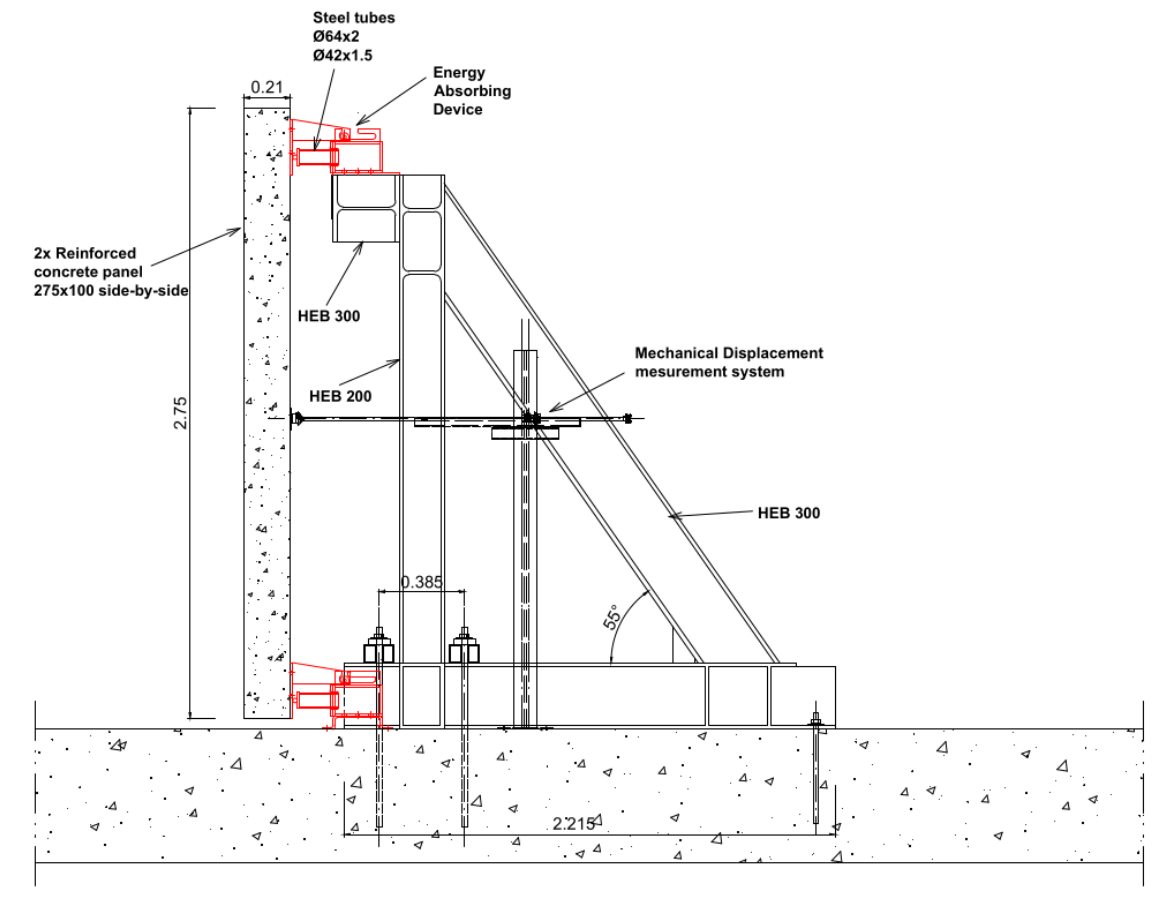
Figure 3. Blast test setup scheme.